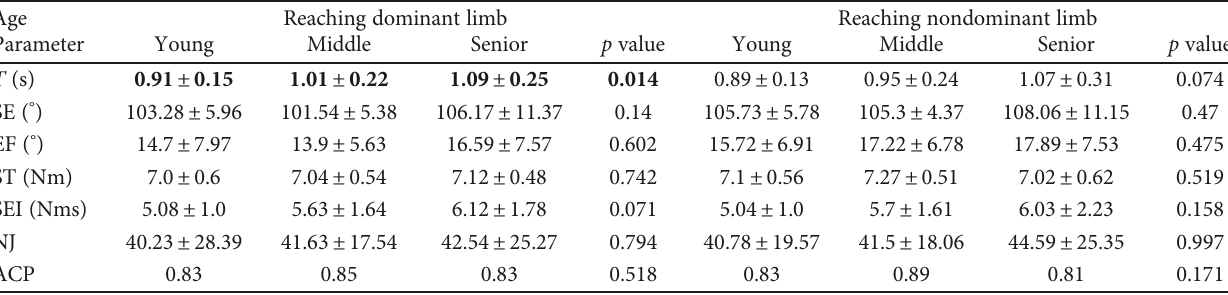
Table 5: Age subset: